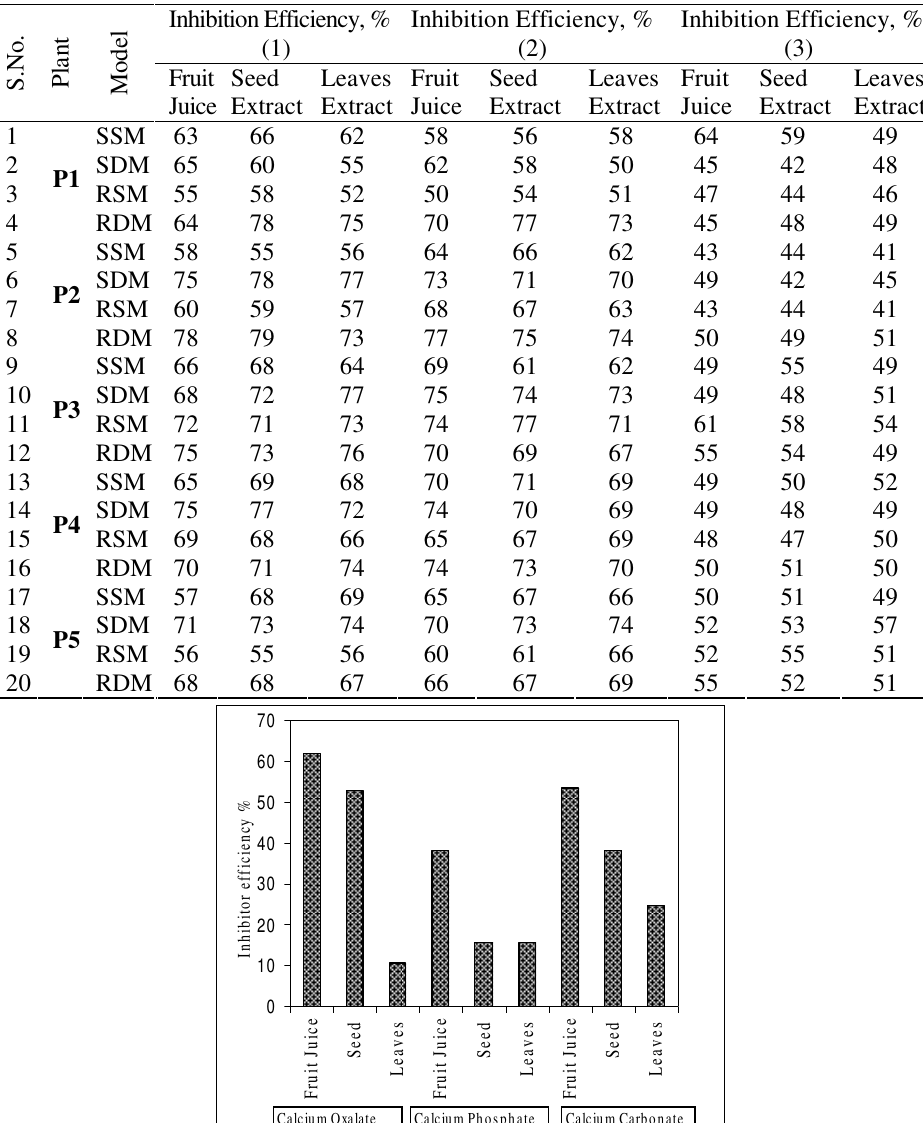
1. Inhibition of (1) Calcium oxalate (2) Calcium phosphate and (3) Calcium carbonate Mineralization by medicinal plants.